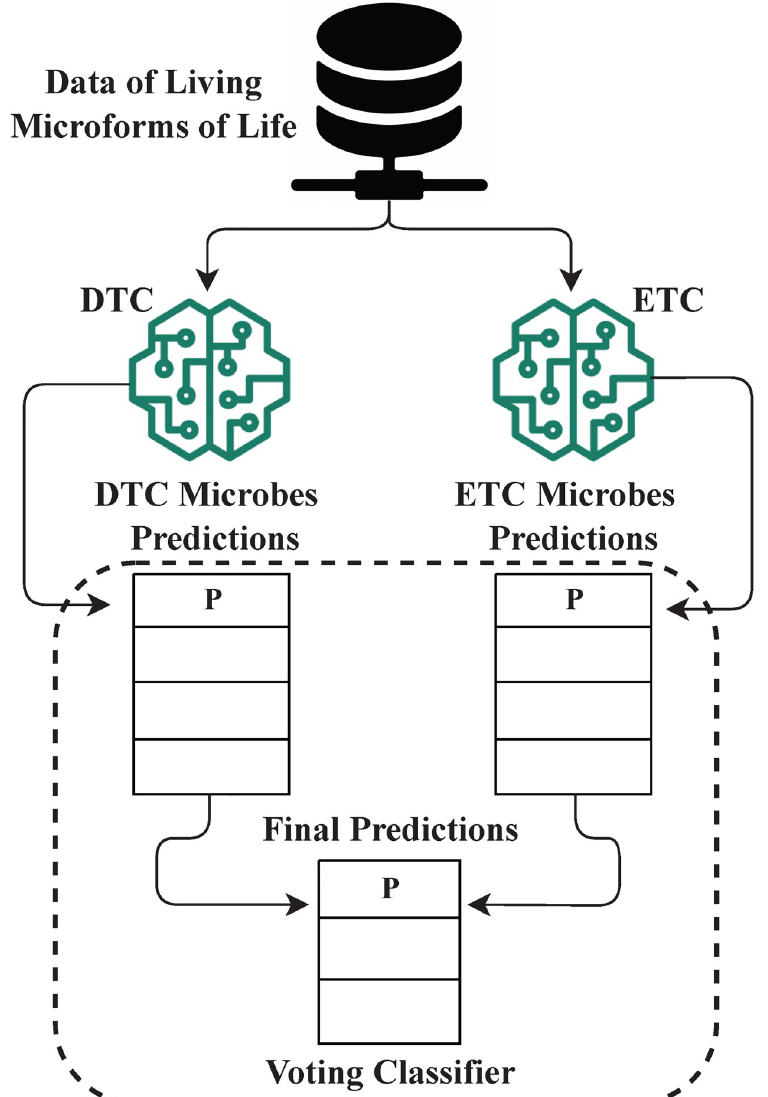
Fig 6. The architecture of the proposed HMC approach showing the voting process for the hybrid